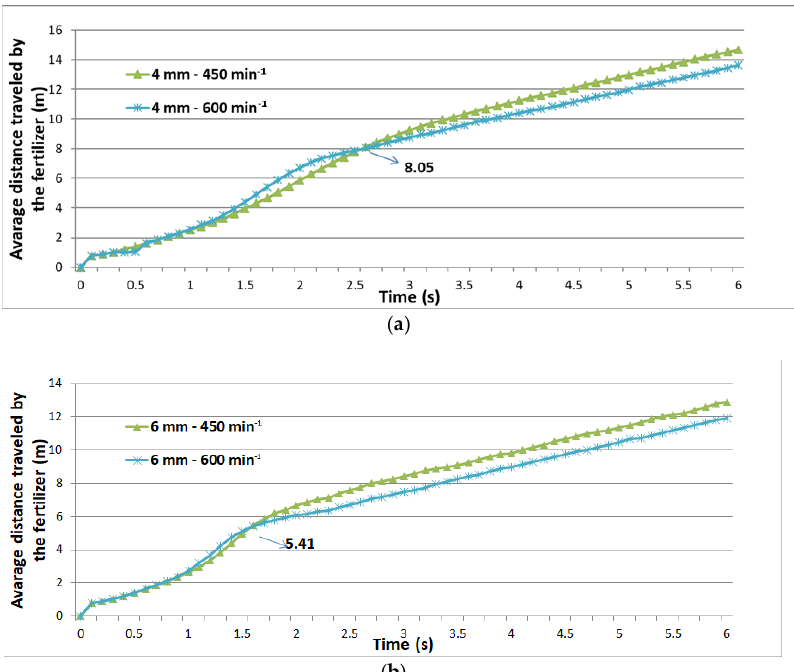
Figure 5. Average distance traveled by the particles of fertilizer I (a) and fertilizer II (b), when the discharge flow rate was 200 g s − 1 . The highest average distance traveled by the fertilizer particles was 14.69 m, when the rotation speed of the spinning discs was 450 min − 1 . However, the shortest average distance traveled by the fertilizer particles was 11.94 m, when the rotation speed of the spinning discs was 600 min − 1 .